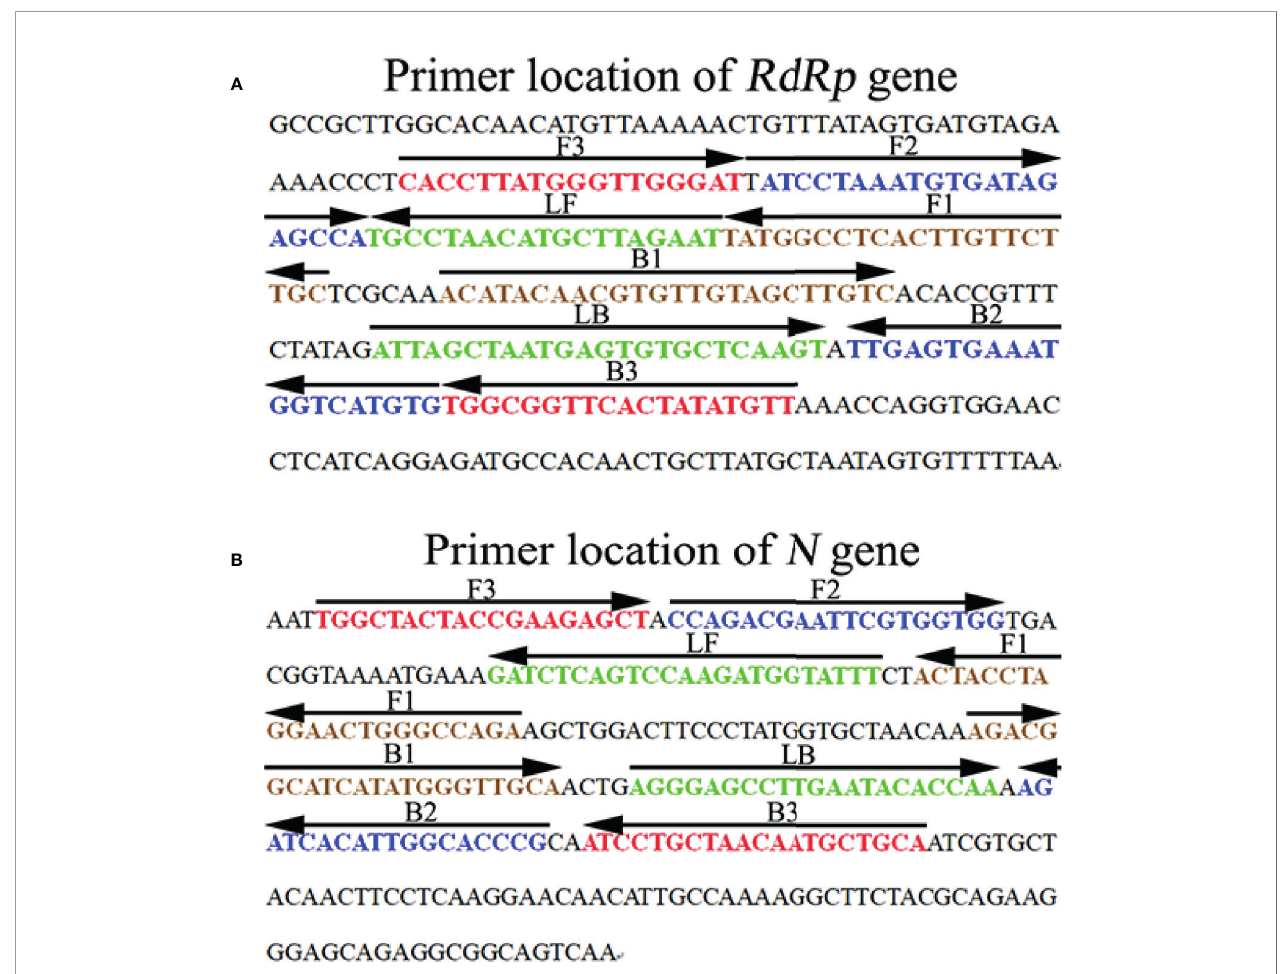
FIGURE 1 | Sequence and location of the RdRp (A) and N (B) genes used to design SARS-CoV-2 mRT-LAMP primers. The nucleotide sequence of the sense strand of the RdRp and N is shown in the diagram. Right arrows and left arrows indicate sense and complementary sequences which were used in the current study,